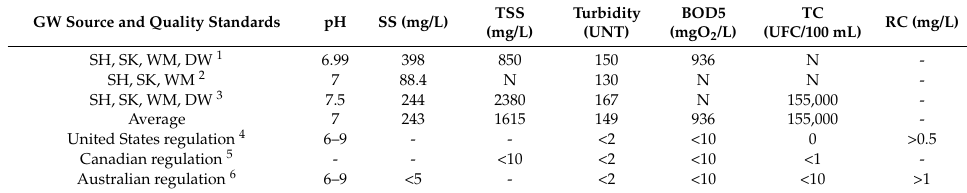
Table 2. Quality of collected greywater reported in studies from Colombia and international regulations. GW Source and Quality Standards pH SS (mg/L) TSS (mg/L) SH, SK, WM, DW